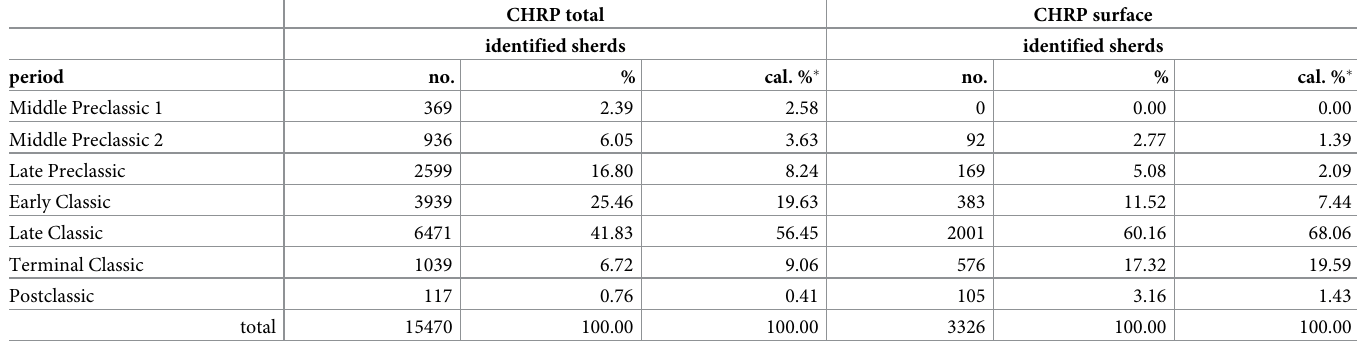
Table 2. Ceramic frequencies and percentages by period, corresponding to all identifiable pieces collected both on the surface and in test pits (CHRP total) and to surface collections only (CHRP surface).